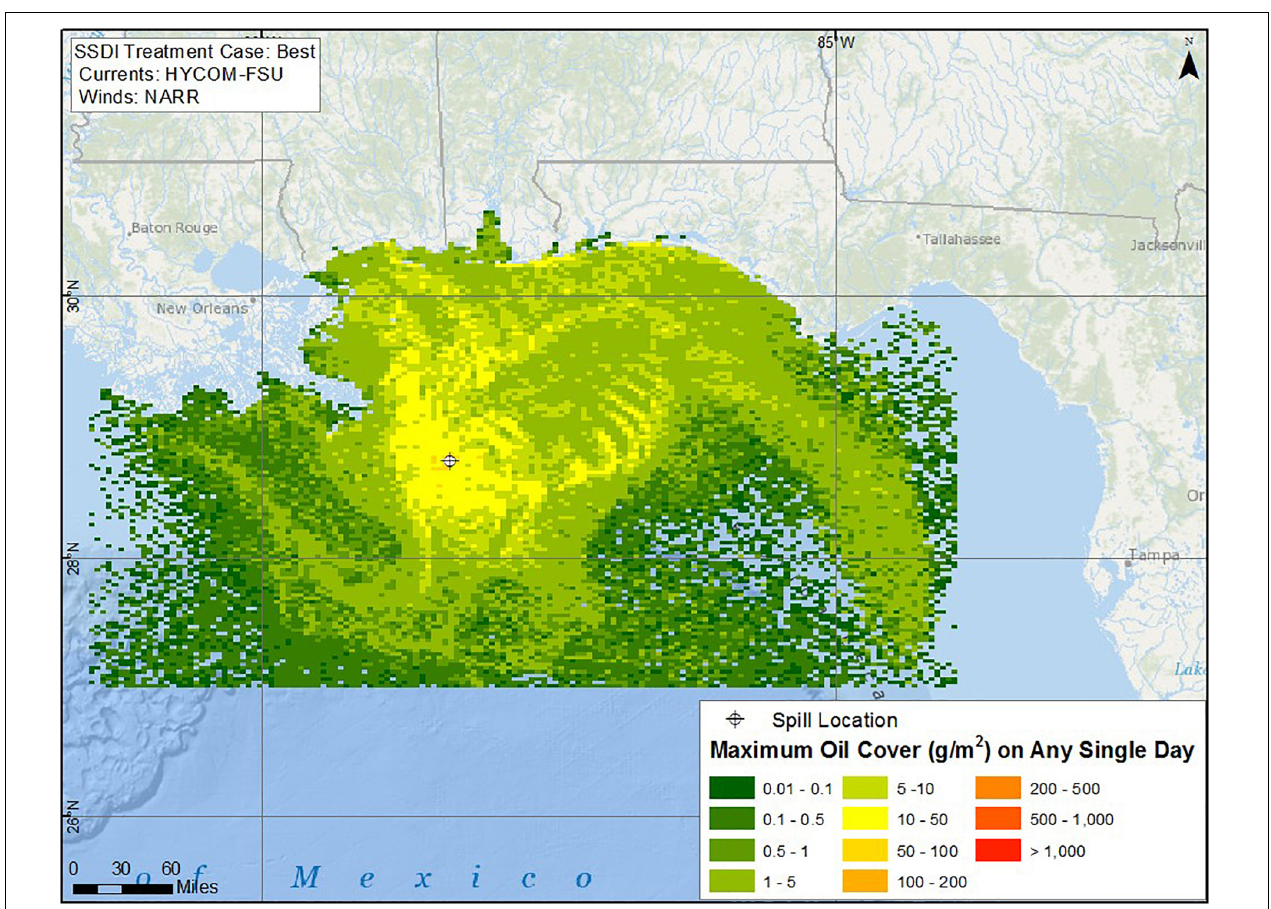
FIGURE 5 | Modeled maximum amount of oil in each grid cell at any time in the simulation (as g/m 2 averaged over the grid cell), based on the base case model